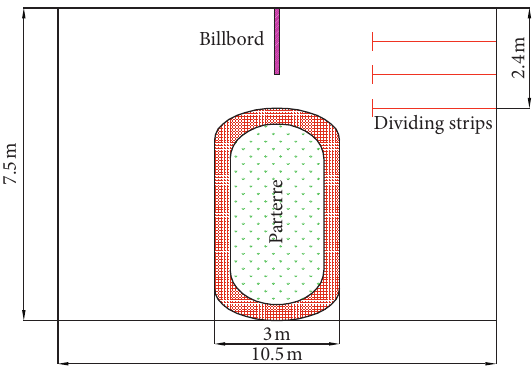
Figure 5: Common walking area used for